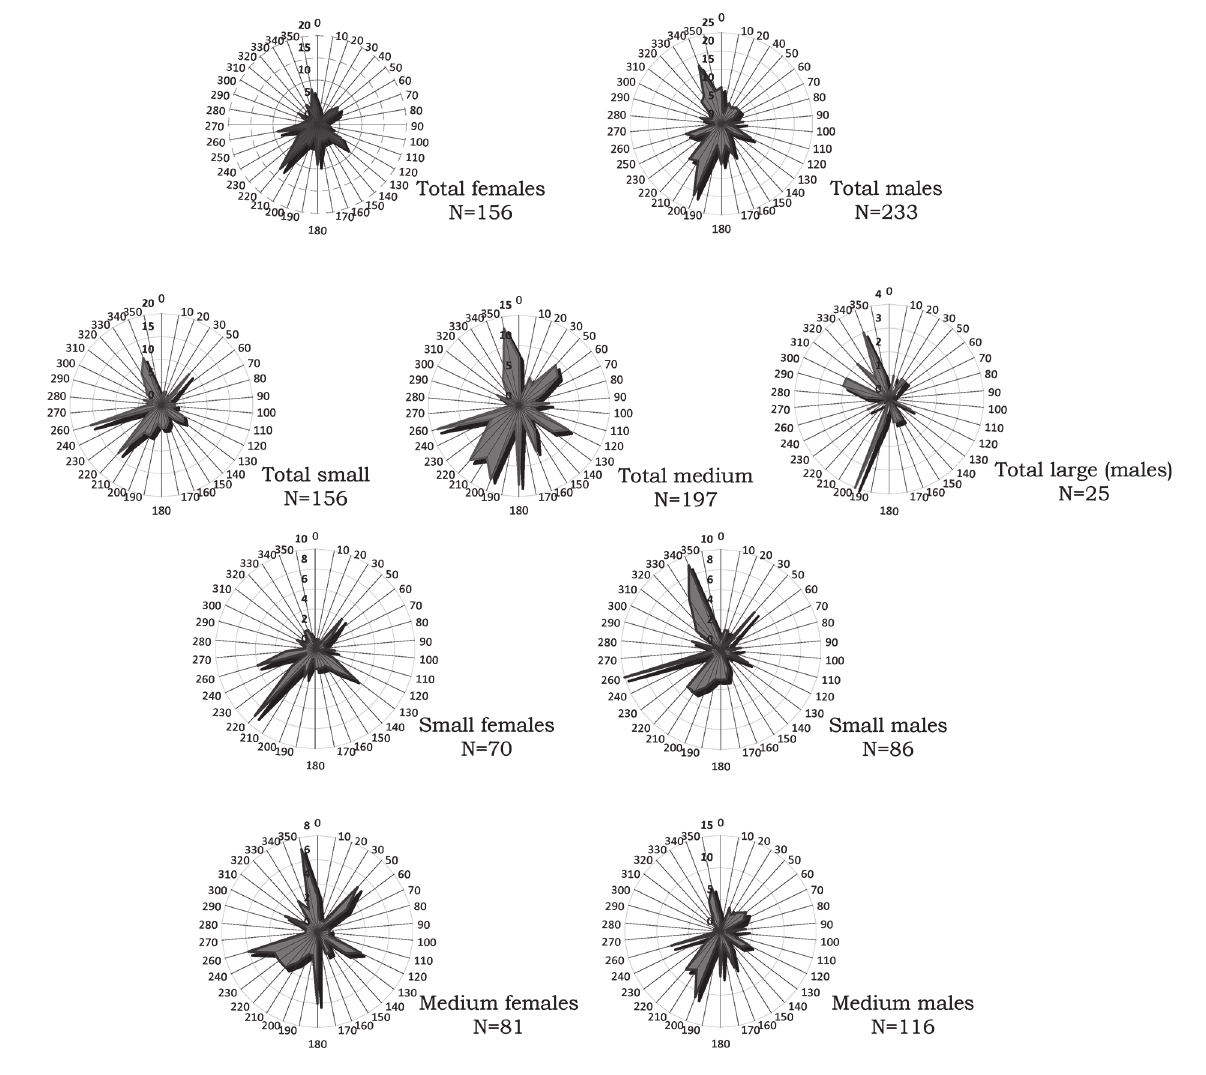
Fig . 4. – Circular distribution for lobsters recaptured presented by sex and size